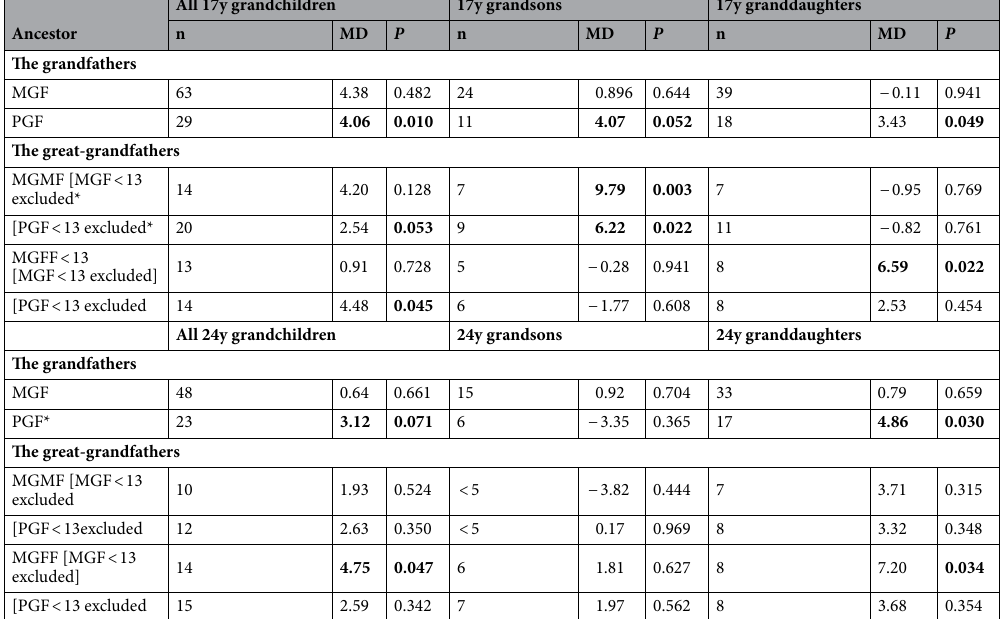
Table 4. Unadjusted associations between fat mass of the F3 population according to whether their grandfathers or great-grandfathers had started smoking regularly before the onset of puberty (< 13), after eliminating the maternal or paternal grandfathers who had started smoking < 13. Comparisons are with ancestors who had started smoking between ages 13 and 16. P values in bold are using 1-tailed tests since the hypothesis was that there would be excess fat mass for early